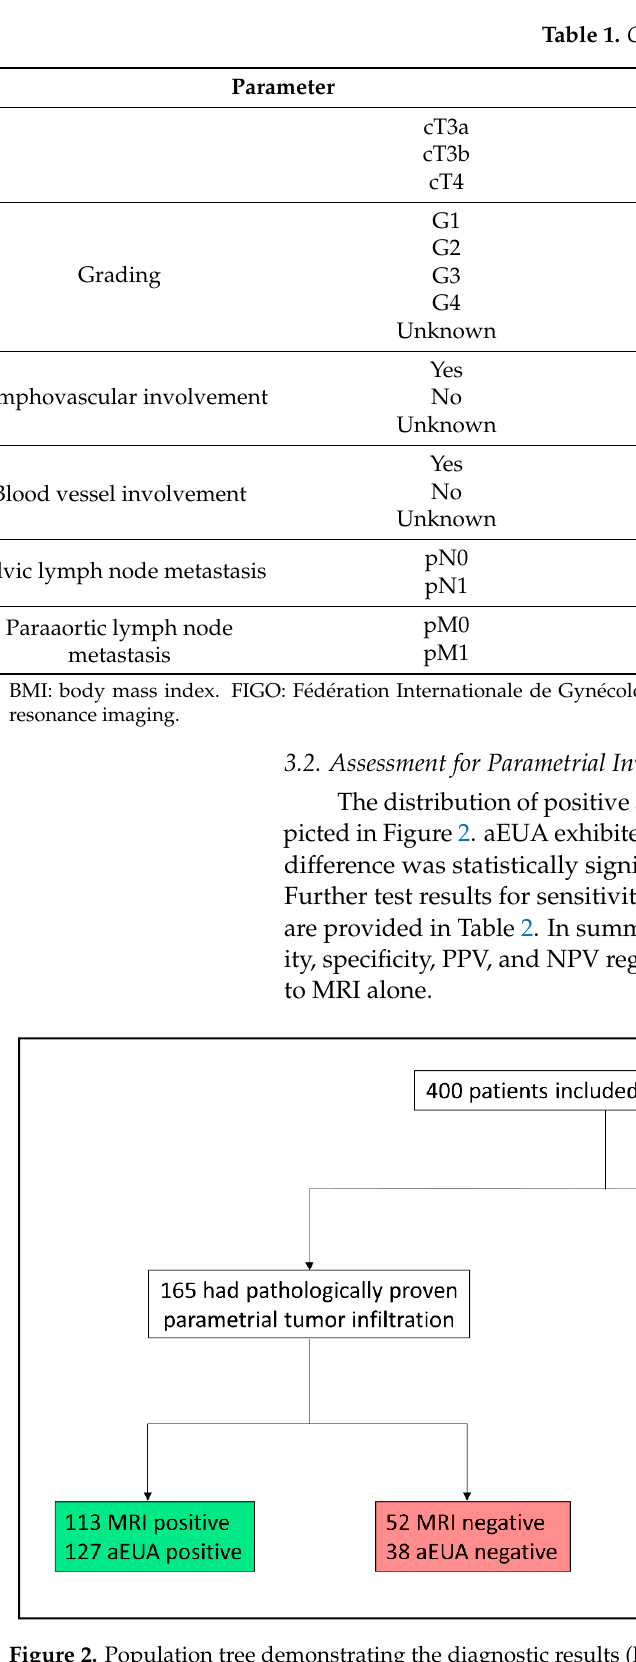
Figure 2 . Population tree demonstrating the diagnostic results (MRI and aEUA) within our study population. All accuracy calculations are based on these numbers. aEUA: clinical examination under general anesthesia with display of MR images in the operating room. MRI: magnetic resonance imaging.